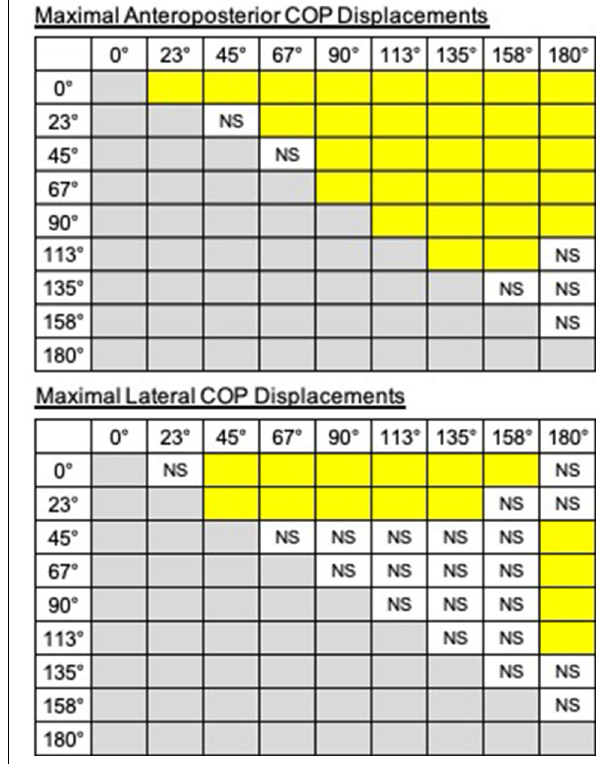
FIGURE 3 | The results of post hoc tests on displacements of COP (top: anteroposterior, bottom: lateral). The pairs are shown in the columns colored in yellow show significant differences ( P < 0.05). NS,